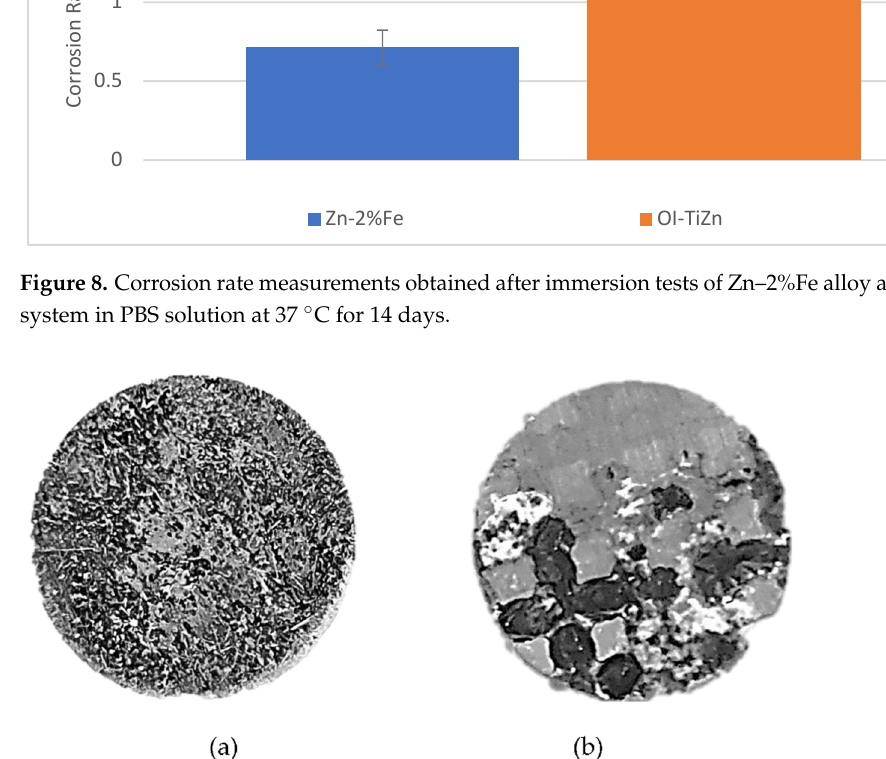
Figure 10. A magnified view of the galvanic corrosion attack in the vicinity of the Ti-base lattice after immersion test for 14 days. An electrochemical analysis in terms of potentiodynamic polarization of Ti–6Al–4V alloy, biodegradable Zn–2%Fe alloy, and the OI–TiZn system is shown in Figure 11. This indicates that the polarization curve of the OI–TiZn system was shifted to higher current densities, indicating an increased corrosion rate [43]. This was supported by Tafel extrap- olation (Table 2), which clearly revealed that the corrosion rate of the OI–TiZn system was higher by about three orders of magnitude as compared to the Ti-base lattice, and by less than two orders of magnitude as compared to the biodegradable Zn–2%Fe alloy. This electrochemical outcome clearly demonstrates the dominant effect of the infiltrated Zn– 2%Fe alloy on corrosion tendencies of the OI–TiZn system. In addition, these results com- ply with the results obtained by the immersion tests, and the assumptions related to the substantial effects of galvanic corrosion.